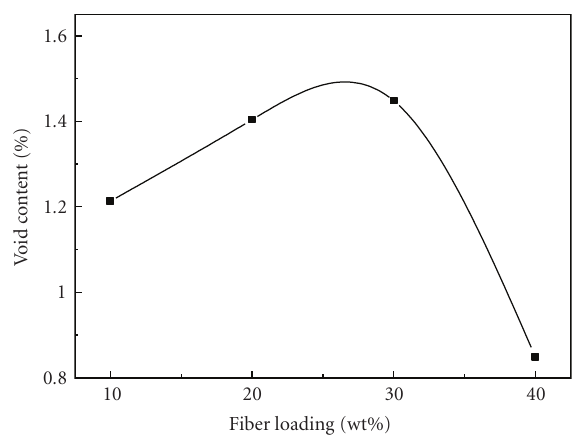
Figure 2: E ff ect of fiber loading on void content of composites.